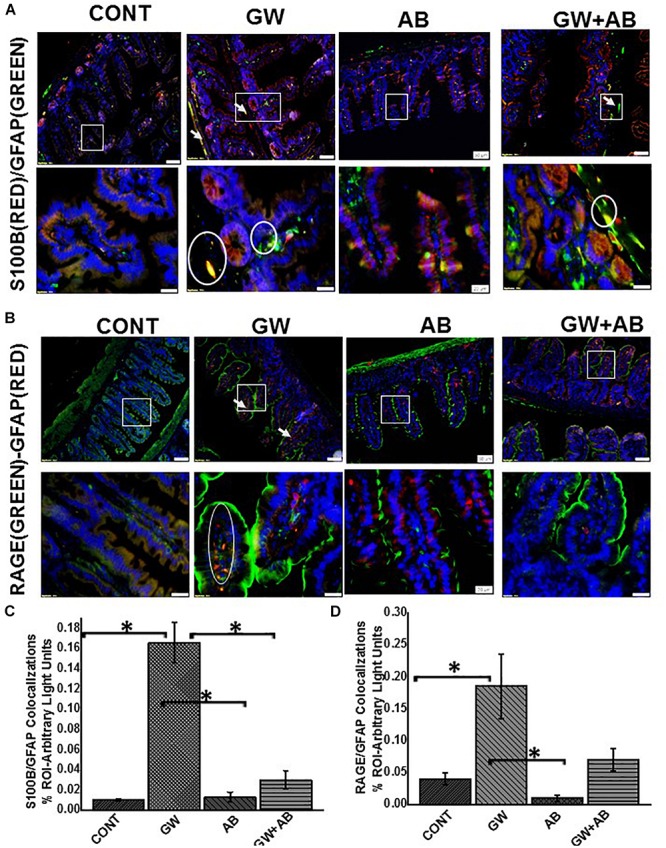
(A) Expression levels of S100B in EGC. Protein expression levels of S100B in EGC was determined by co-staining S100B with GFAP and assessed by immunofluorescence microscopy at (top panel magnification 200X; scale 100 μm and bottom panel magnification 600X; scale 20 μm). Images show immunoreactivity in distal part of the small intestine for vehicle control treated mice (CONT, n = 9), gulf war chemical treated mice (GW, n = 9) and gulf war chemical treated mice, mice treated with antibiotics only (AB, n = 4) and mice co-exposed with antibiotics (GW + AB, n = 9). (C) Quantitative morphometric analysis of immunoreactivity of GFAP/S100B (yellow) is represented as colocalizations events per field from randomly chosen microscopic fields (% ROI) (∗P < 0.05). (B) Expression of RAGE in EGC Protein expression levels of RAGE in EGC was determined by co-staining RAGE with GFAP and assessed by immunofluorescence microscopy at (top panel magnification 200X; scale 50 μm and bottom panel magnification 600X; scale 20 μm). Images show immunoreactivity in distal part of the small intestine for vehicle control treated mice (CONT, n = 9), gulf war chemical treated mice (GW, n = 9) mice treated with antibiotics only (AB, n = 4) and gulf war chemical treated mice co-exposed with antibiotics (GW + AB, n = 3). (D) Corresponding quantitative morphometric analysis of immunoreactivity of GFAP/RAGE (yellow) is represented as colocalizations events per field from randomly chosen microscopic fields (% ROI) (∗P < 0.05).